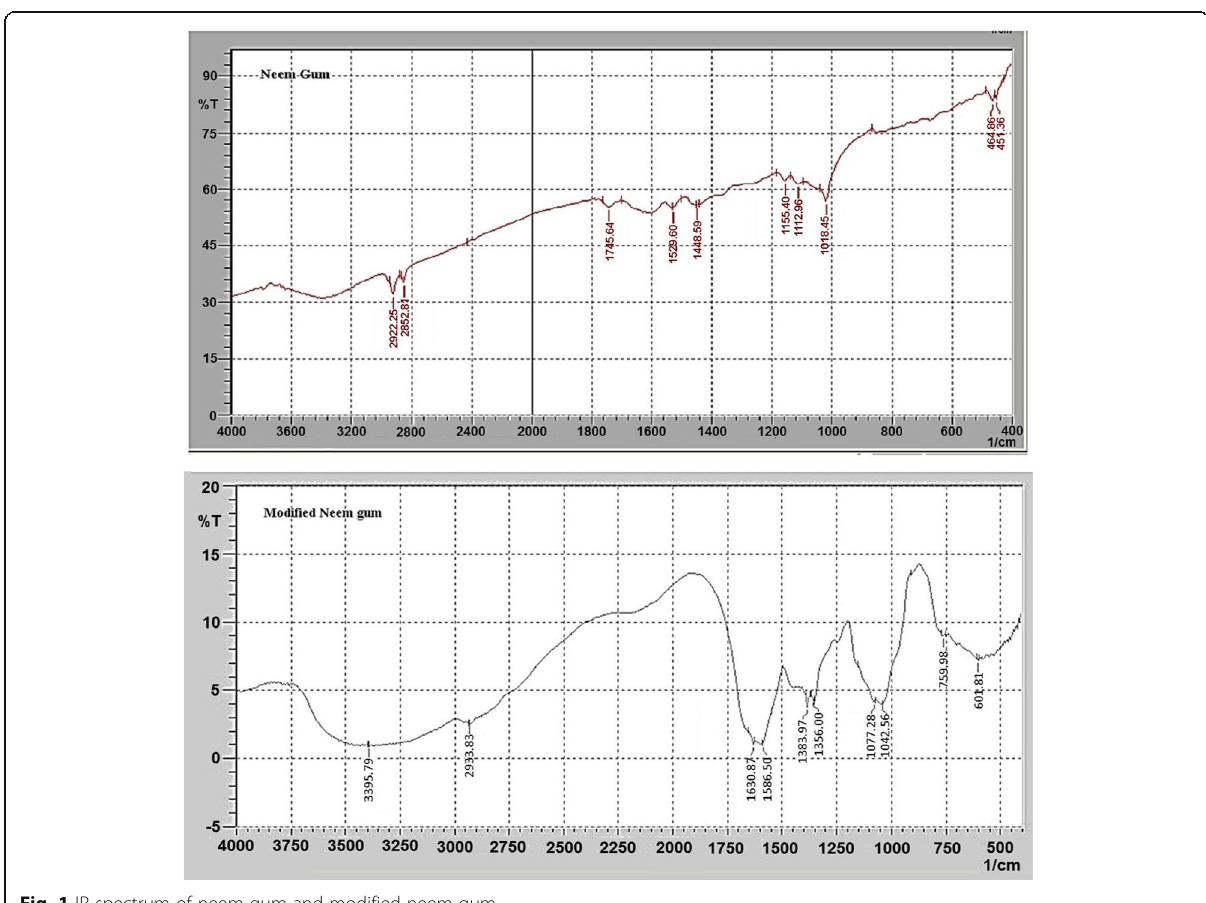
Fig. 1 IR spectrum of neem gum and modified neem